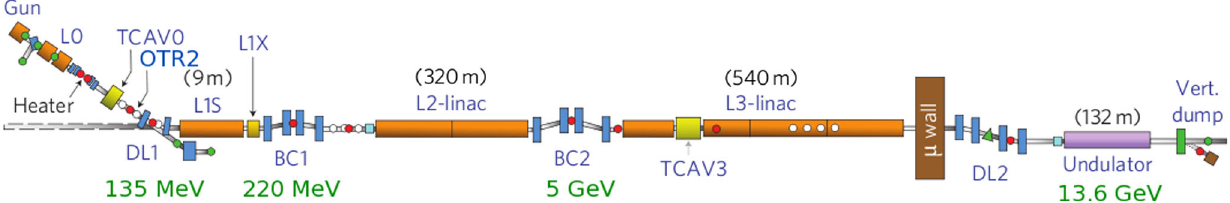
FIG. 1. Layout of the LCLS, with injector sections, main linac S -band sections (L1S, L2, L3), one X -band linac section (L1X), two bunch compressor chicanes (BC1 and BC2), two dog-leg beam lines (DL1 and DL2), and a 132-m-long